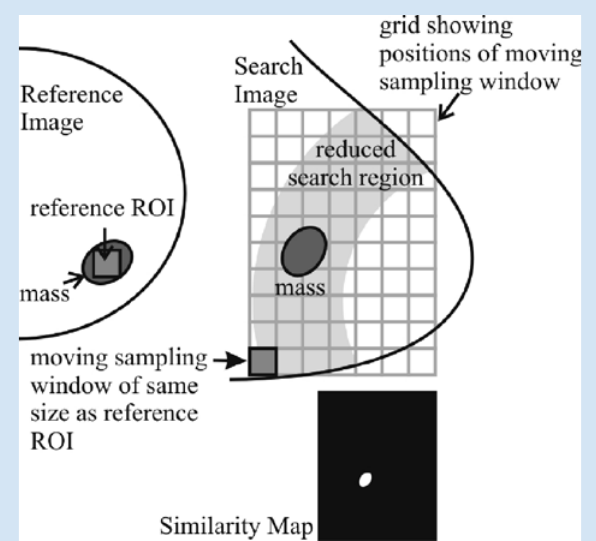
Fig. 2. Schematic (not to scale) of the matching algorithm. The location of the reference ROI was used to reduce the search region in the search image. Textural characteristics of the reference ROI are compared with textural characteristics of equivalently sized sub-images in the search image. The comparison process results in a similarity map. The brighter the regions on the similarity map, the greater the similarity. The similarity map is generally smaller than the search image because the sampling win- dows are >1 pixel and the windows are stepped in increments >1 pixel.